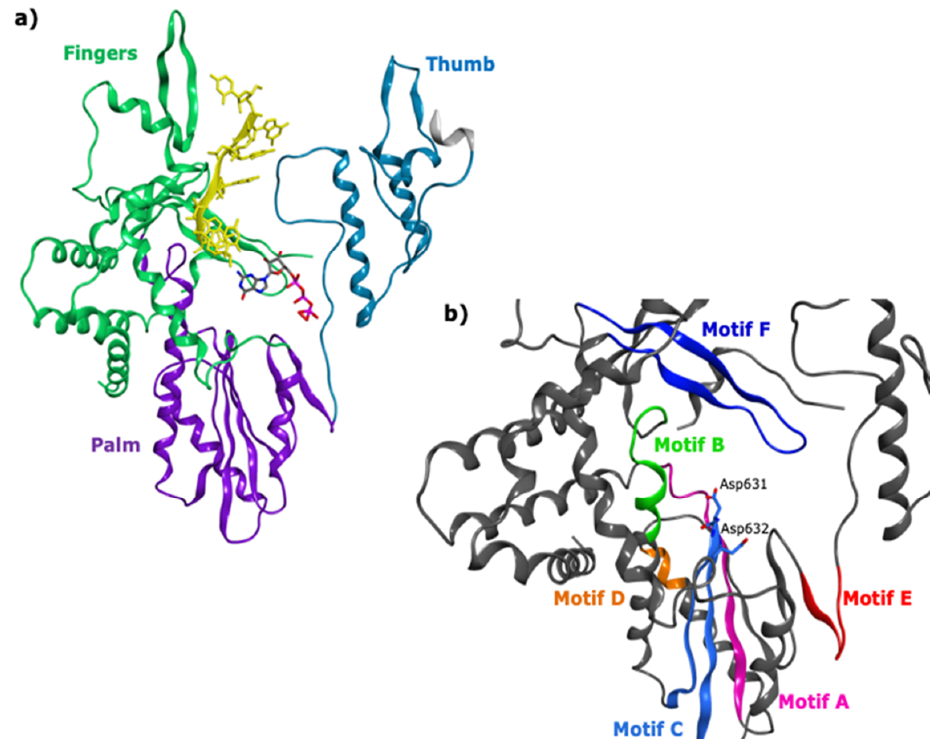
Figure 2. ( a ) Domains of the HRV VP1 co-crystallised with an RNA fragment and GTP (PDB ID 2R7X, resolution 2.8 Å); ( b ) colour-coded motifs A-F in the 2R7X crystal structure, with the catalytic residues Asp631 and Asp632 highlighted (part of the conserved GDD sequence).